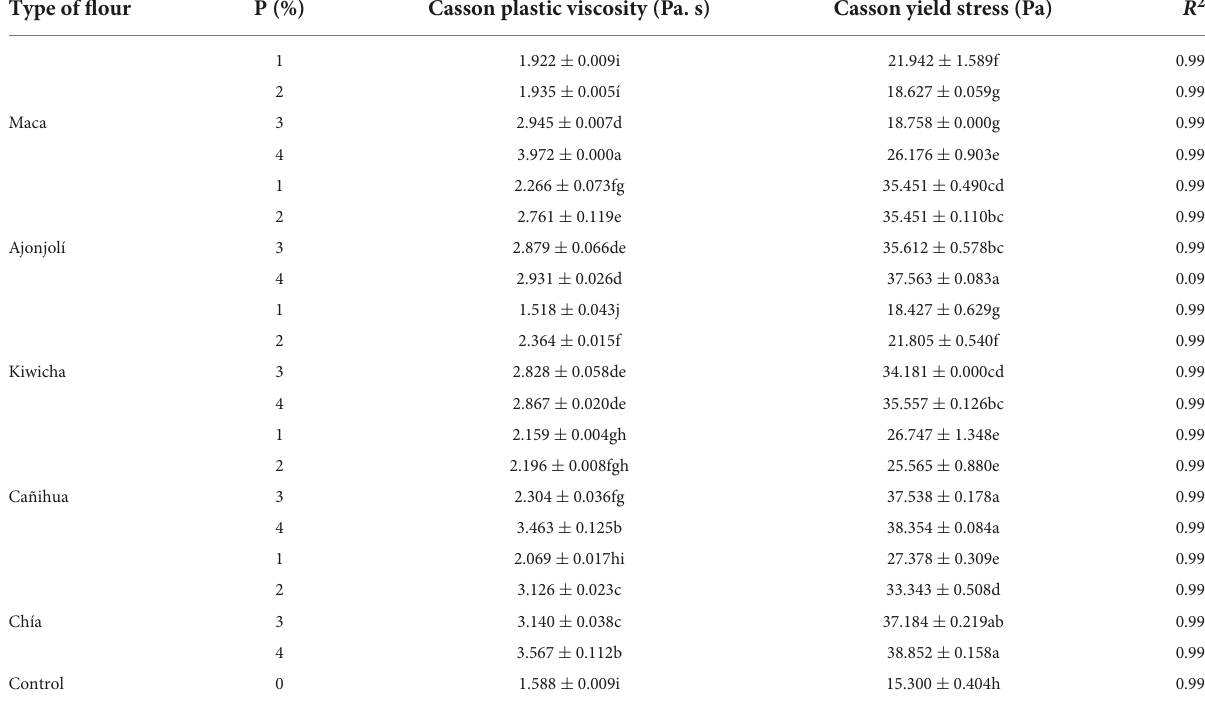
TABLE 2 Rheological properties of dark chocolates enriched with high nutritional value flours. Type of